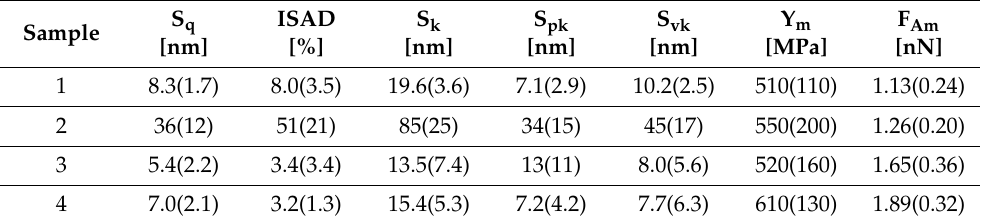
Table 1. Mean values of nanomechanical parameters in groups 1, 2, 3, 4.